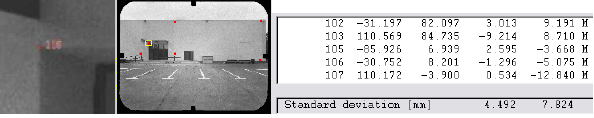
Figure 5. Remaining errors and the standard deviation after the exterior orientation (North facade)